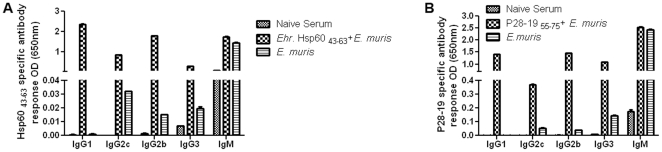
Antibody isotypes in mice immunized with Ehrlichia Hsp60 43–63 and P28-19 55–75 peptides.(A) Mice vaccinated with Ehrlichia Hsp60 43–63 peptide had higher levels of IgG1, IgG2c, IgG2b, and IgG3 compared to unvaccinated mice after bacterial challenge. (B) Mice vaccinated with P28-19 55–75 peptide had higher levels of IgG1, IgG2b, IgG2c, and IgG3 compared to unvaccinated mice after bacterial challenge. The data were expressed as mean plus standard deviation and three mice per group were included for analysis.